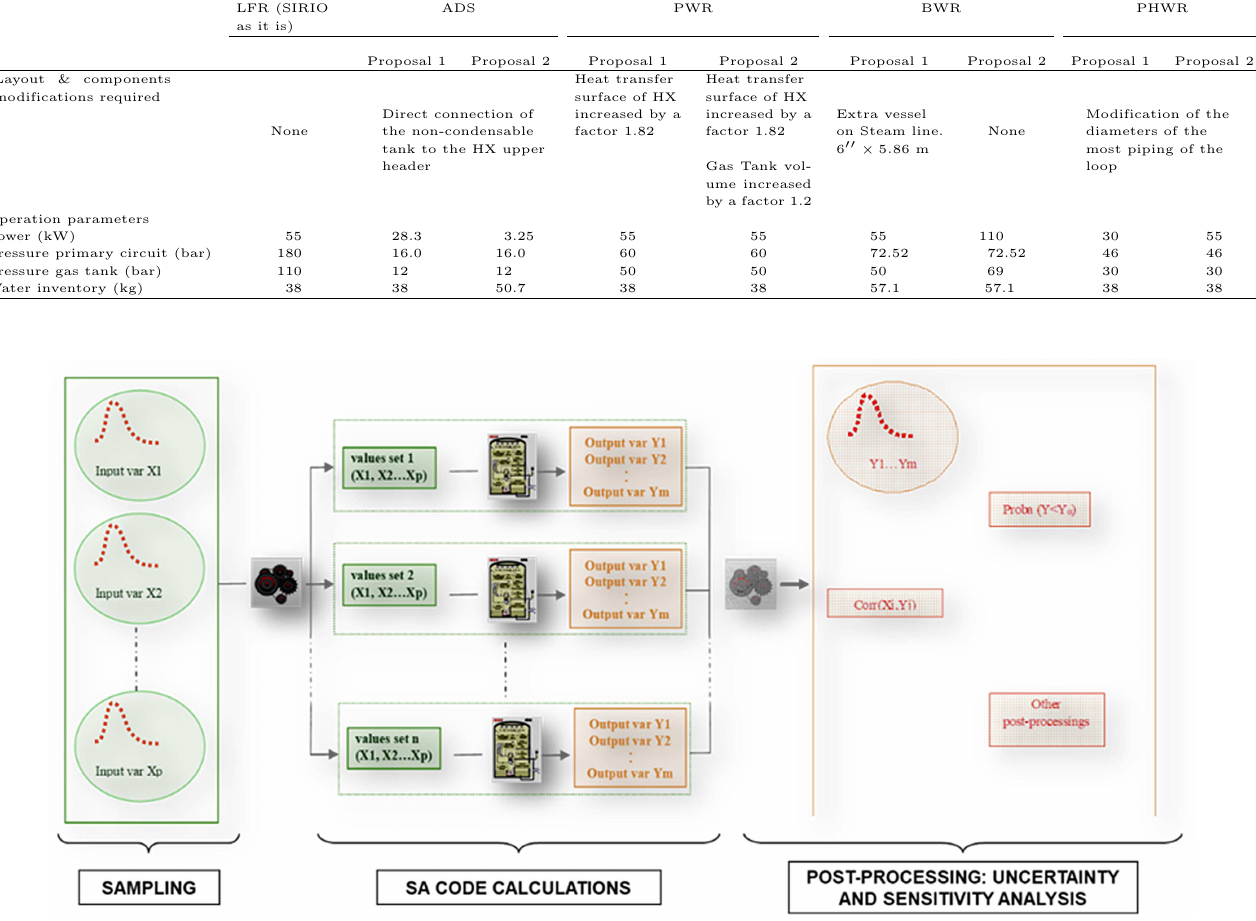
Fig. 5. Sketch of uncertainty propagation being applied in MUSA